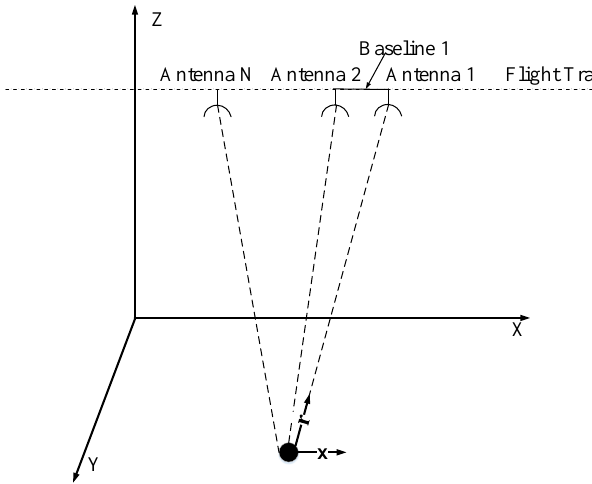
Figure 1. Multichannel synthetic aperture radar (MSAR) system